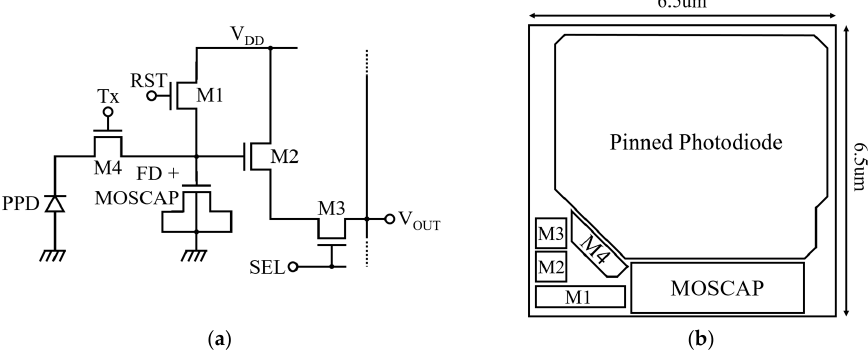
Figure 2. Proposed pixel for multiple charge transfer technique: ( a ) Schematic of the pixel; ( b ) Simplified pixel layout.